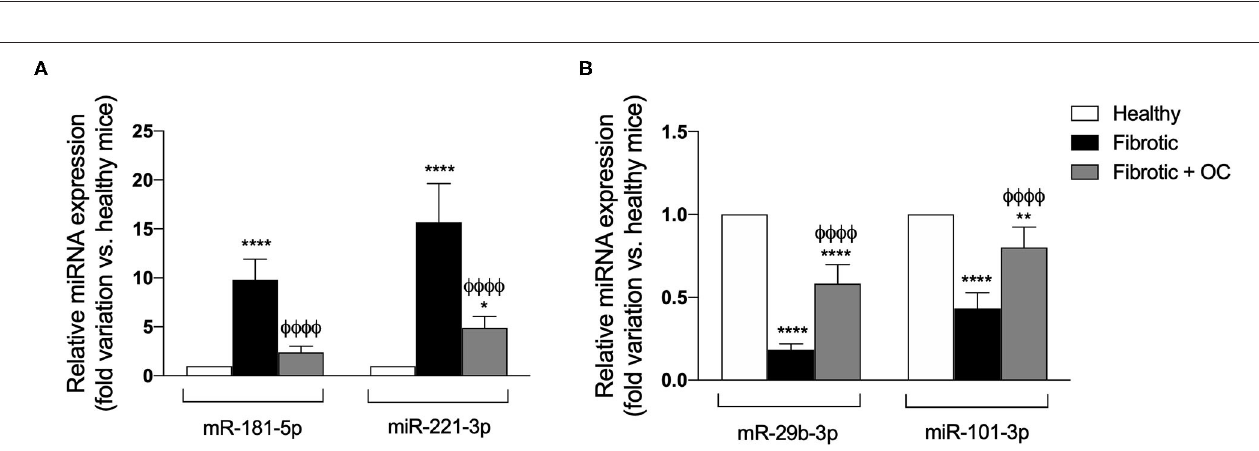
FIGURE 7 | Effect of OC on the hepatic expression of the fibrogenic genes α -SMA and COL1A1 in the mouse model of fibrosis. * P < 0.05 vs. control, φ P < 0.05 vs. fibrotic mice. Results are obtained by analyzing 6 animals per group in triplicate and have been analyzed by one-way ANOVA followed by the Tukey’s post hoc test.